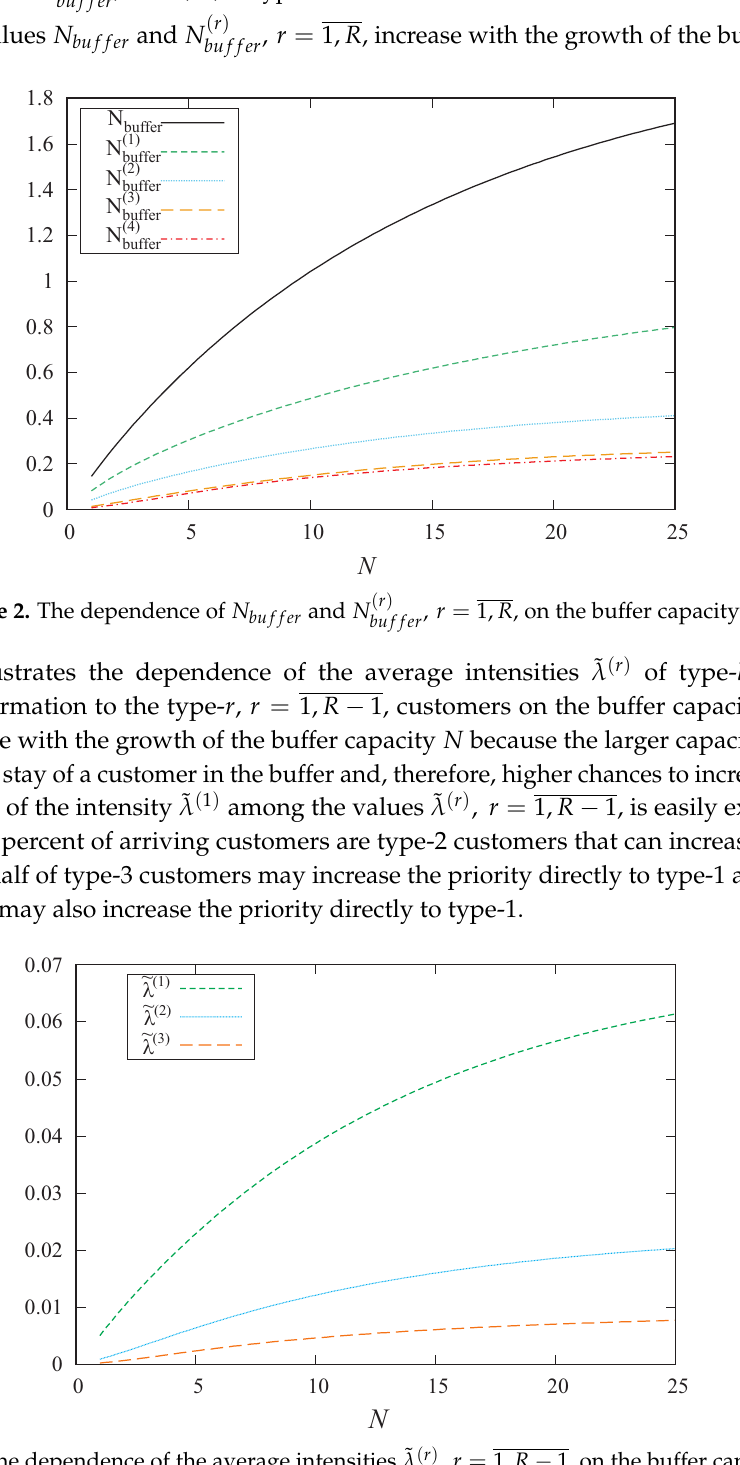
Figure 3. The dependence of the average intensities ˜ λ ( r ) , r = 1, R − 1, on the buffer capacity N